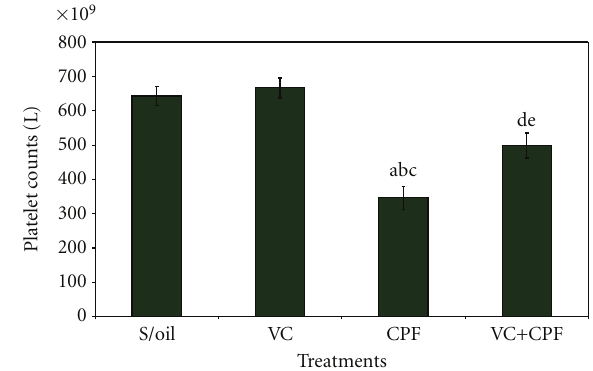
Figure 1: E ff ect of chronic exposure to soya oil (S/oil), vitamin C (VC), and/or chlorpyrifos (CPF) on platelet counts in Wistar rats. a P < . 01 versus soya oil group; b P < . 01 versus vitamin C group; c P < . 05 versus vitamin C+chlorpyrifos group; d P < . 05 versus soya oil group; e P < . 05 versus vitamin C group. Values are mean ± SEM of 5 animals per group.